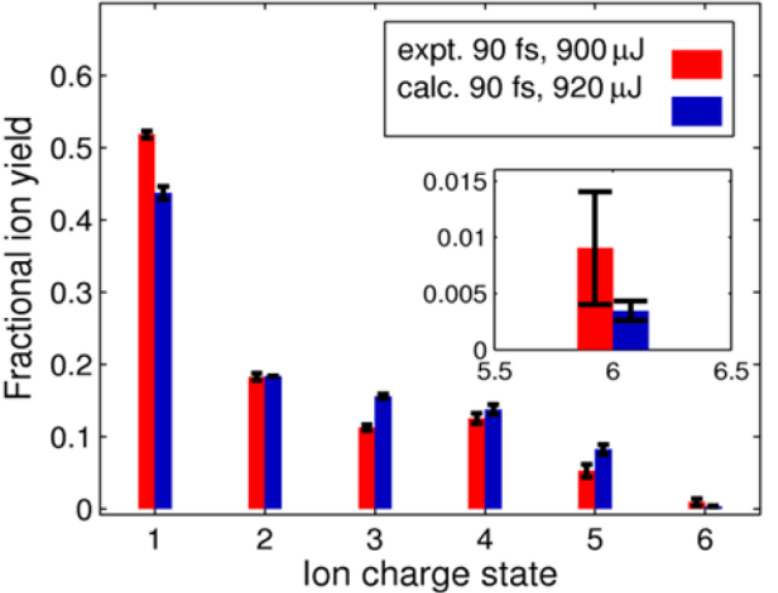
energy was 485 eV, the pulse duration was 90 fs, and the pulse energy was 0.61 mJ.